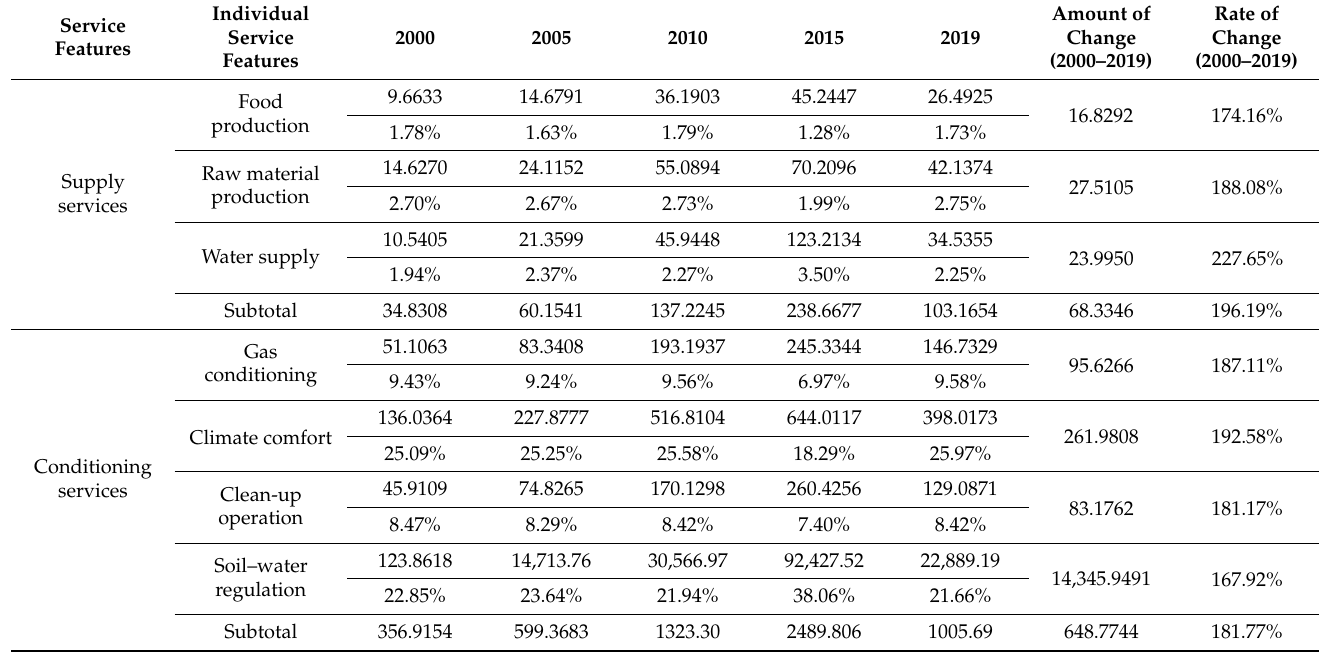
Table 8. Total value of ecosystem services by land type in Qilian Mountain National Park (Gansu Area) and the corresponding proportion (billion USD